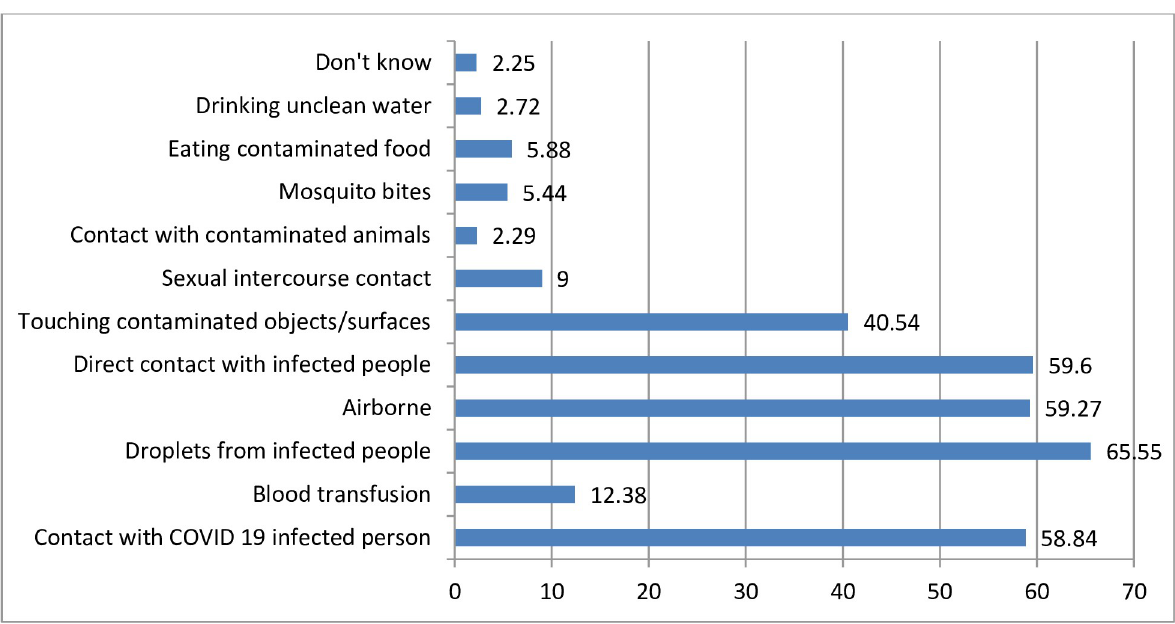
PLOS ONE | https://doi.org/10.1371/journal.pone.0257373 October 20,